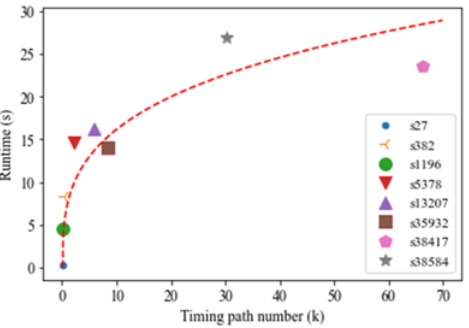
Figure 12. Relationship between the number of timing paths and optimization runtime.